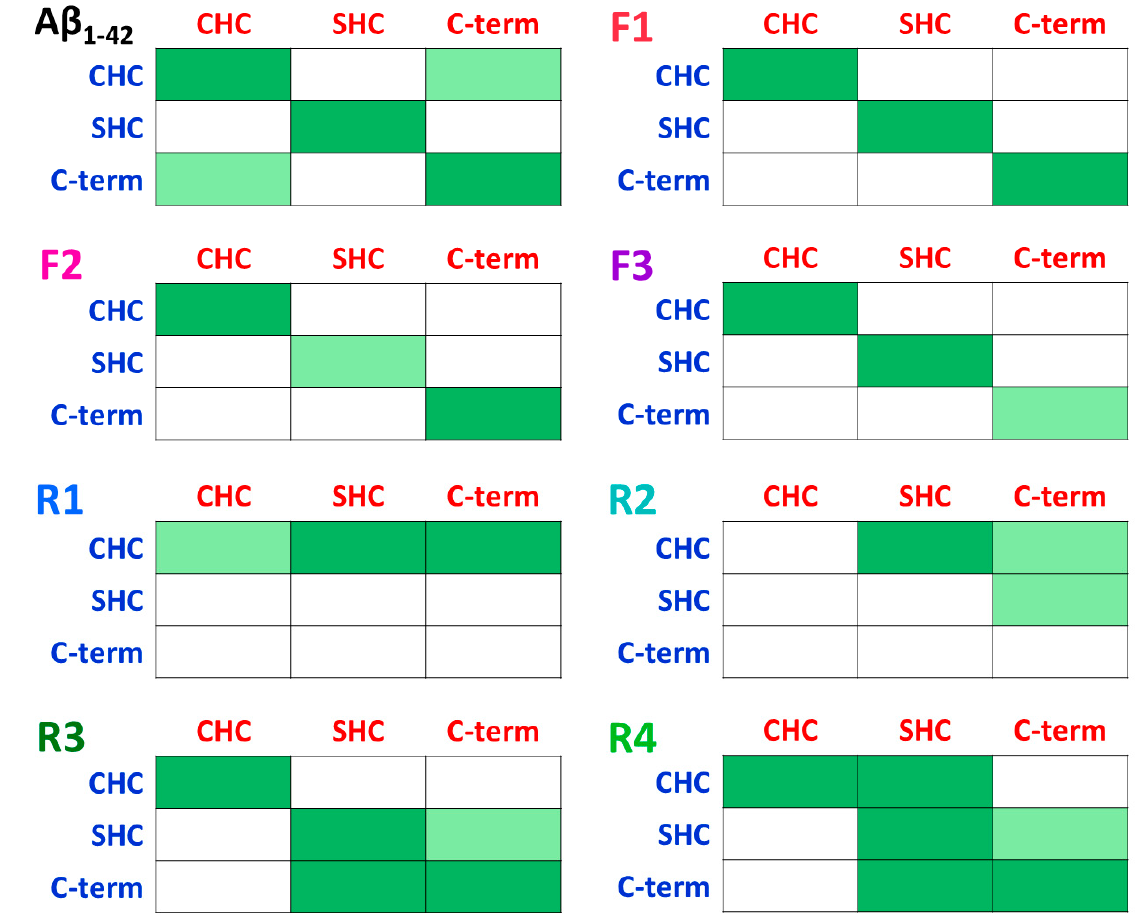
Figure 4. Contacts between the domains (that play a role in primary nucleation) of the monomers (monomer 1: blue; monomer 2: red) within the A β dimers in the fibril-like A β dimer in solution, in the absence of IDE (top left) [35], and in all models that were studied in the current work: models F1–F3 and R1–R4. Strong interactions (dark green), weak interactions (light green), and none interactions (white).